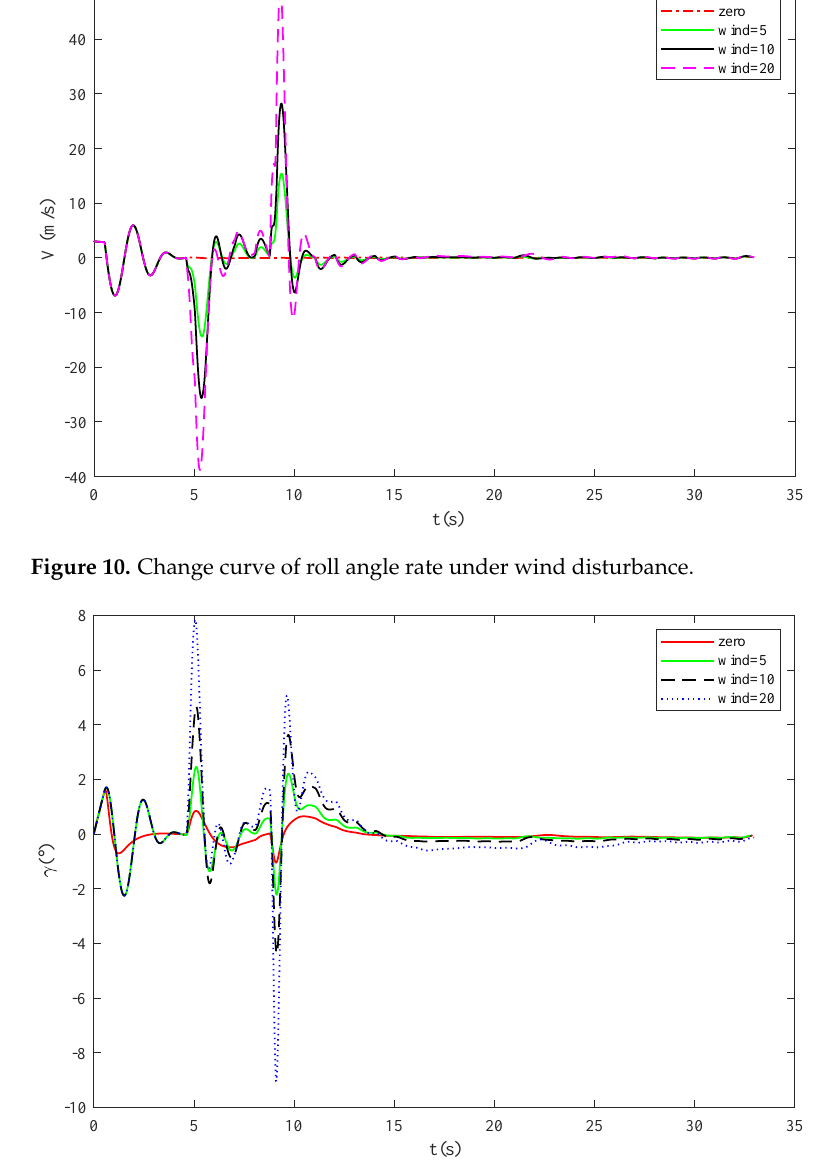
Figure 11. Roll angle response curve under wind